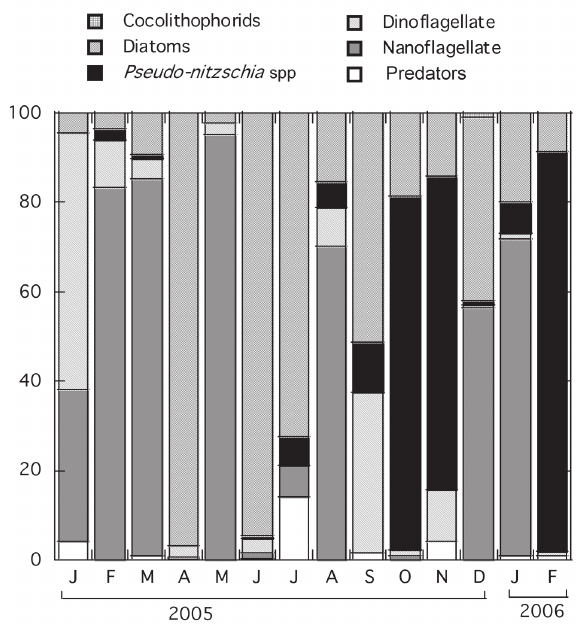
Fig . 8. – relative abundance of the principal phytoplankton group in alfacs Bay (Station 3) the category “predator” includes rotifers, tintinids, ciliates, nauplius, copepods, and larvae of